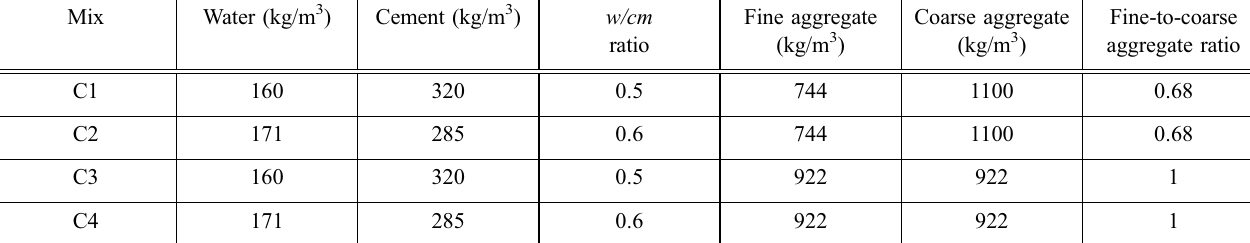
Table 1 Mix proportions of concrete